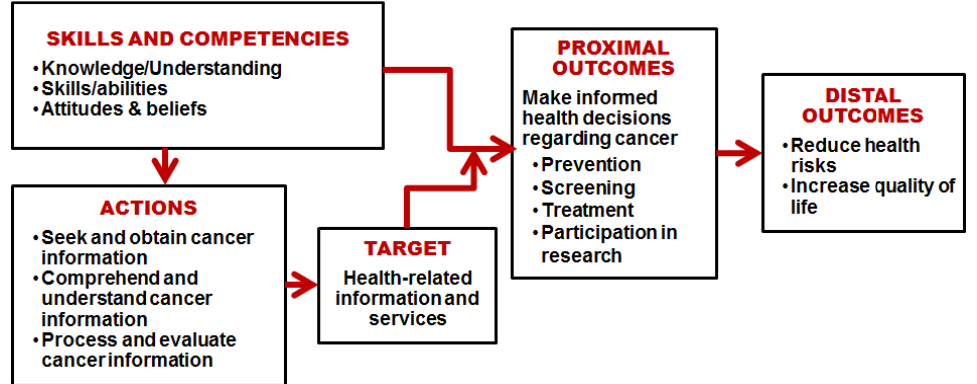
Figure 1. Conceptual framework of the effects of cancer health literacy on cancer-related behaviors and outcomes.